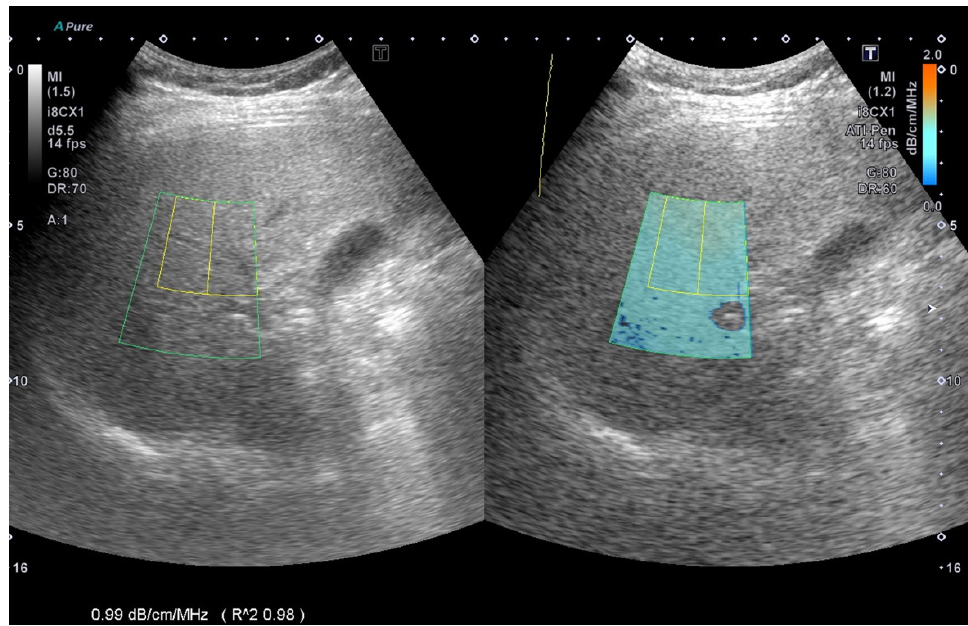
Figure 1. The measurement of ultrasound attenuation imaging. In this case, the ATI is 99 db/cm/MHz × 100 with R 2 : 0.98 as an effective value, ATI: attenuation imaging.